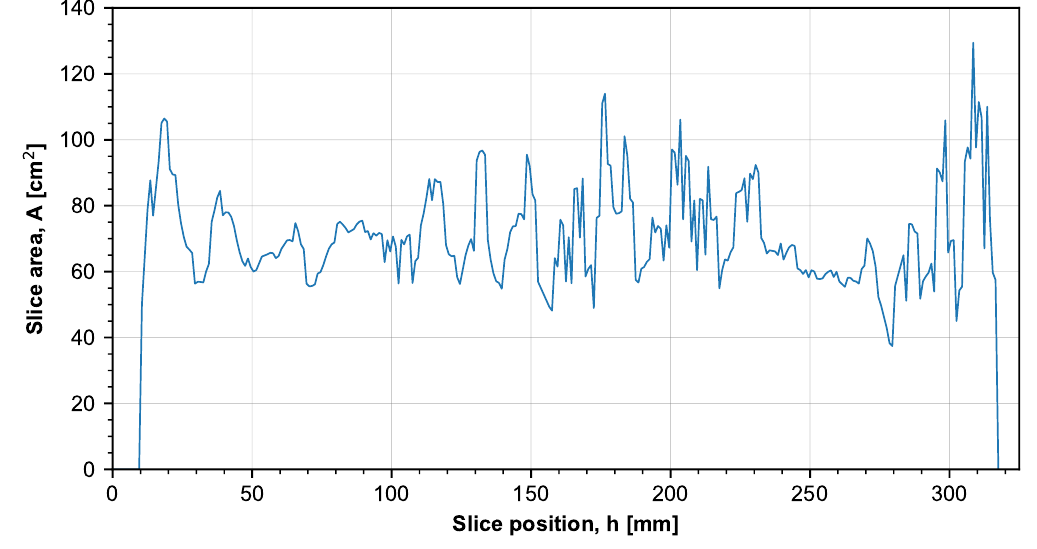
Figure 9. Slice area on individual layers of the build job.